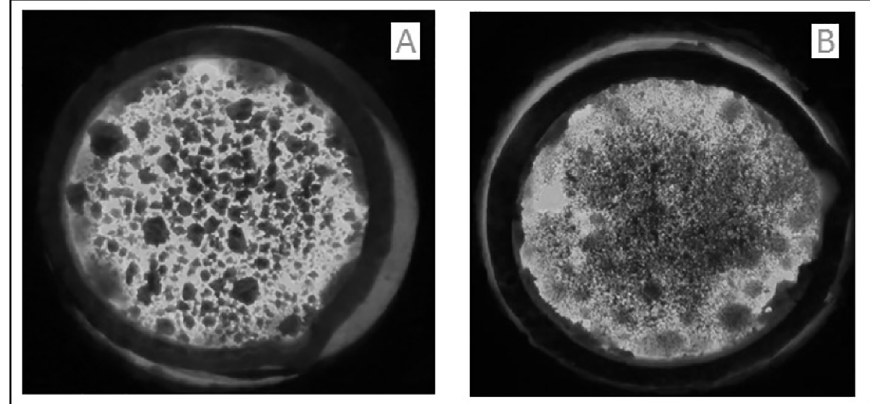
Figure 11. Image obtained after 5 minutes of desulphurization tests with lime: (A) <100 ; (B) range of 0.5 -